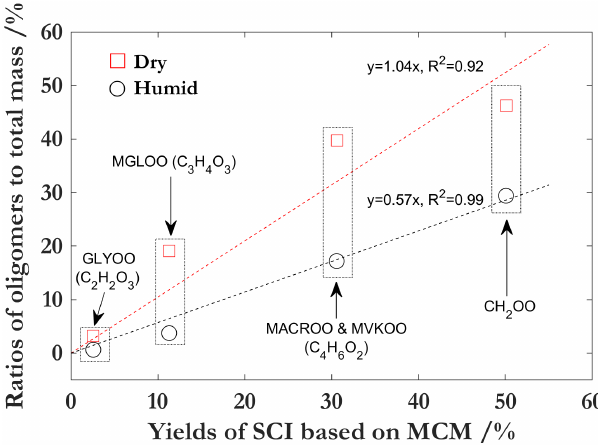
Figure 9. Positive ion mode ESI-Orbitrap mass spectra of SOA from isoprene-H 2 O 2 irradiations under dry conditions. Figure 10. The correlation of yields of the top five SCIs (CH 2 OO, MACROO and MVKOO, MGLOO, and GLYOO) and the ratios of CH 2 O 2 , C 4 H 6 O 2 , C 3 H 4 O 3 , and C 2 H 2 O 3 based oligomers to total mass under dry and humid conditions from isoprene-NO 2 ir- radiations. Only the oligomers that belong to families (M-[SCI] n , n = 0 , 1 , 2 , 3 ... ) with n ≥ 2 were taken into